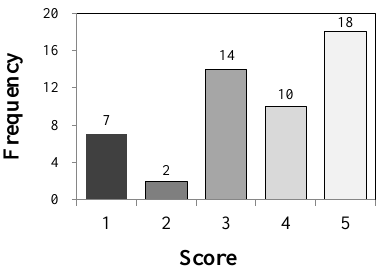
Figure 1. Frequency distribution of the number of the exhibits at each score in the airag contest.